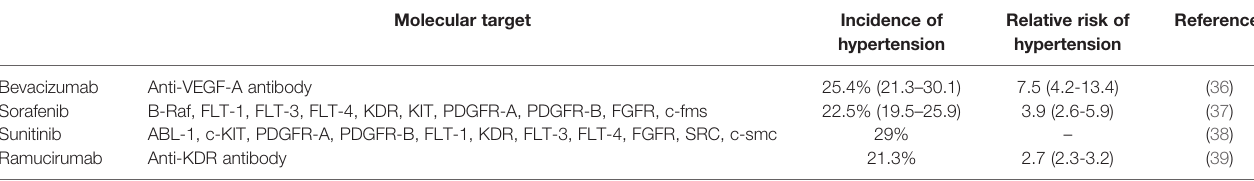
TABLE 3 | Hypertension risk with angiogenesis